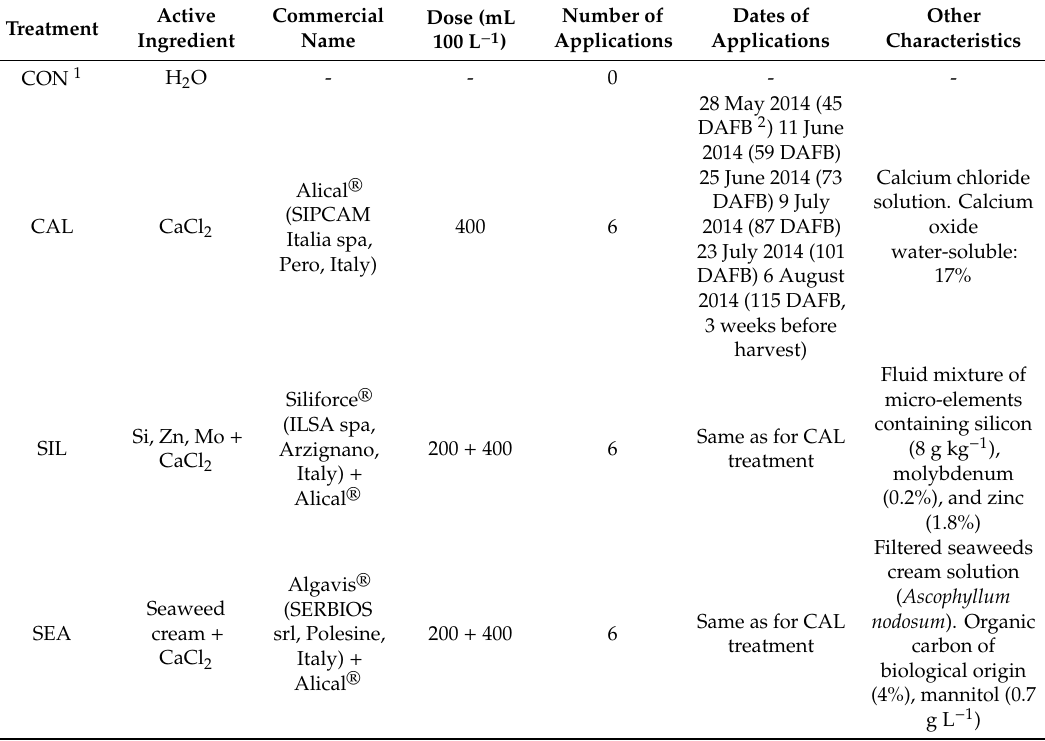
Table 1. Product characterization, properties, and mode of